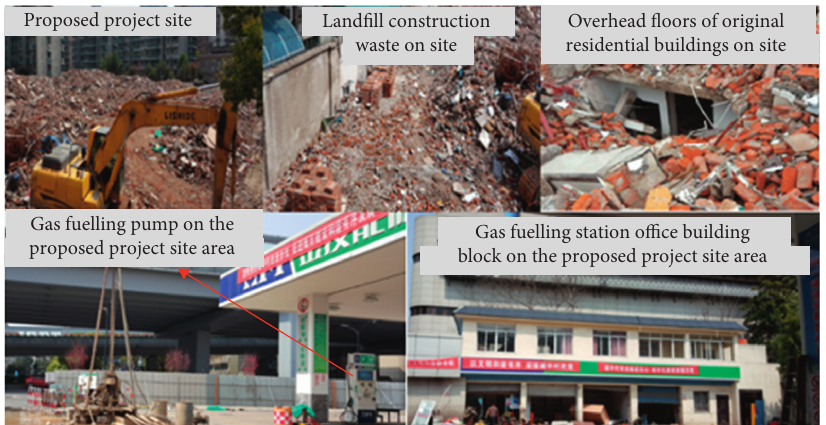
Figure 20: Triumph Unit construction site showing the environmental condition of the site topography and landforms prior to com- mencement of basement